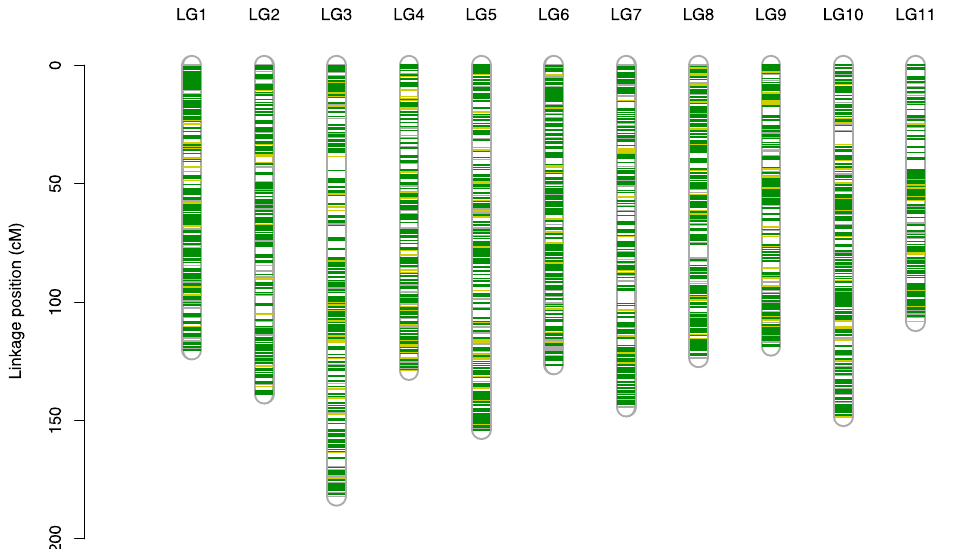
Figure 1. Linkage map of single nucleotide polymorphisms (SNP) distribution on the 11 linkage groups for Cryptomeria japonica (L.f.) D.Don published by Mishima et al. [36]. SNPs that are 80% or more genotyped, less than 80% genotyped, and ungenotyped with the custom primer panel are shown in deep green, light green, and gray, respectively.